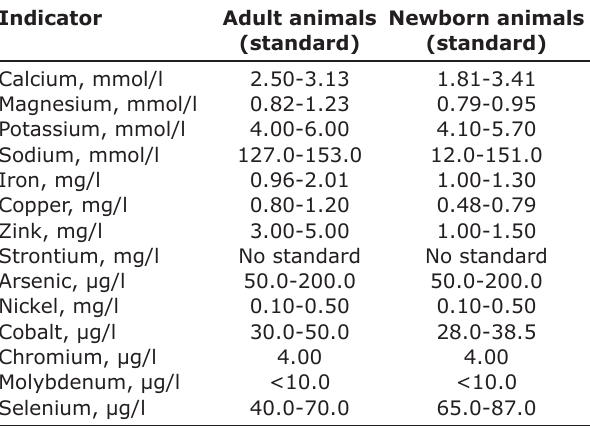
Table-2: Standards of mineral elements content in the blood serum of cows and newborn